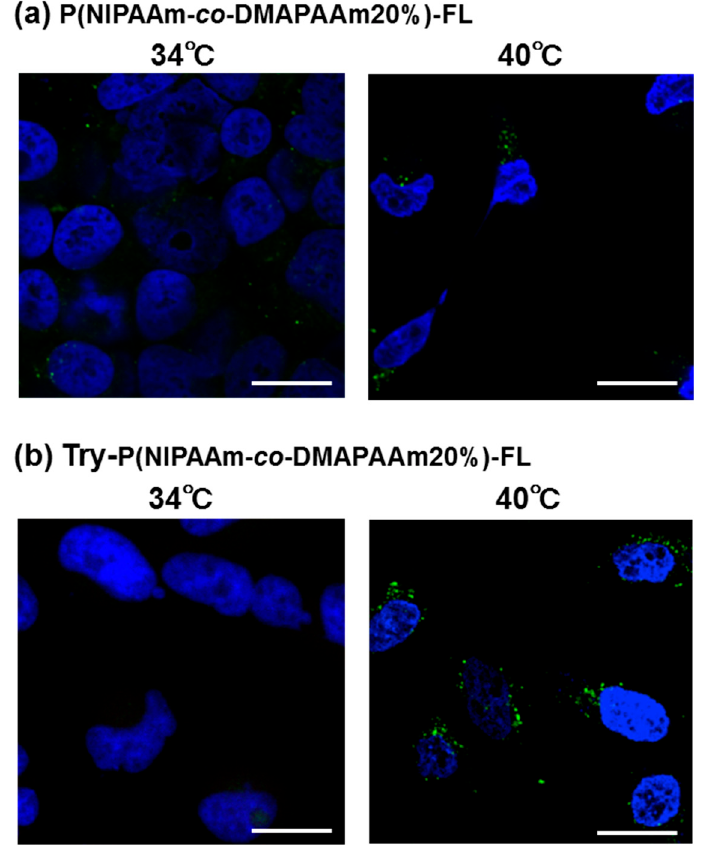
Figure 4. Microscopy images of HeLa cells after 4 h treatment with ( a ) P(NIPAAm- co -DMAAm20%)-FL and ( b ) Tyr-P(NIPAAm- co -DMAAm20%)-FL at 34 °C and 40 °C. The fluorescent probes appear green and the nuclei were stained blue (DAPI). Magnification is 40×; the scale bar represents 20 µm.